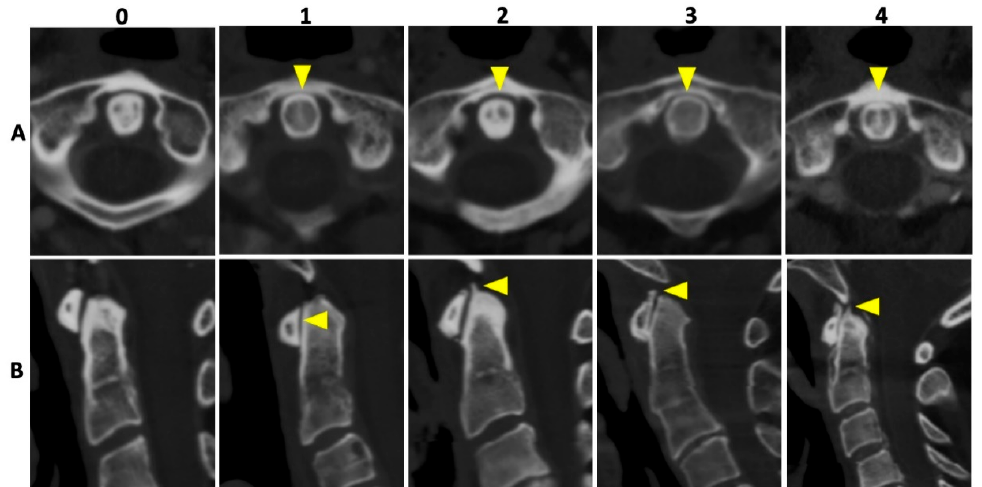
Figure 2 . Imaging examples of osteoarthritis of the atlanto-axial joint. Imaging examples of five different patients according to the Kellgren and Lawrence [18] grading of osteoarthrosis (OA). Upper row ( A ) with axial orientation of 135 kVp images, and lower row ( B ) with sagittal orientation of 135 kVp images, respectively. From left to right (both rows) an increase in OA grading with no OA (0), beginning OA (1), minimal OA (2), moderate OA (3), and severe OA (4) of the atlanto-axial joint is shown (yellow arrowheads).